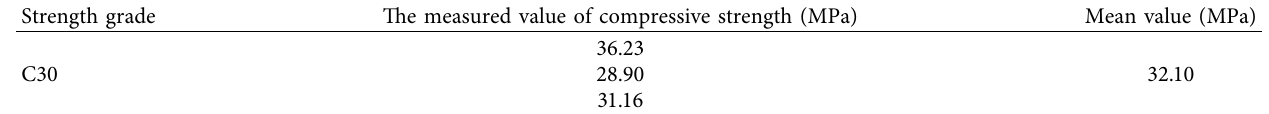
Table 3: Performance test results of concrete.